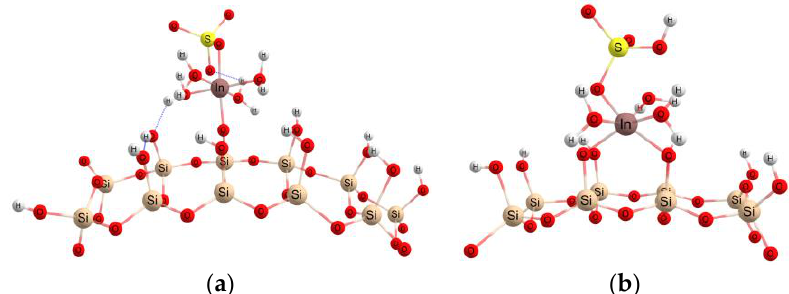
Figure 9. Formation of one ( a ) or two ( b ) In – OSi bonds in the case of interaction with the SBA-15 adsorbent surface.